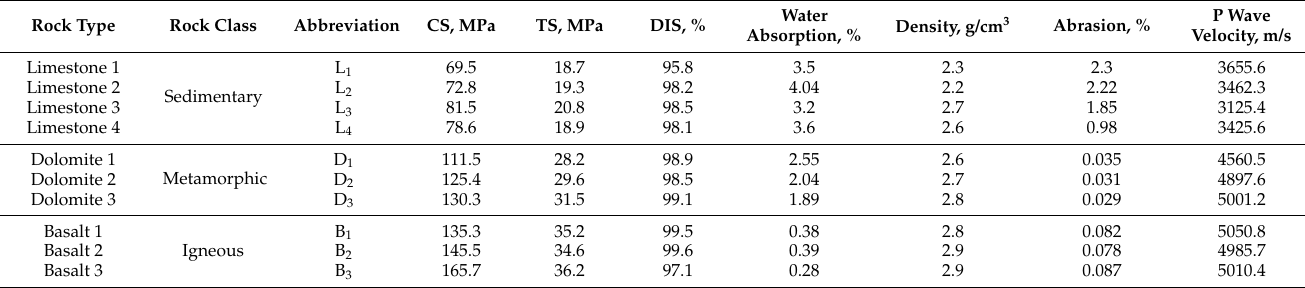
Table 2. Rock types: mechanical and physical